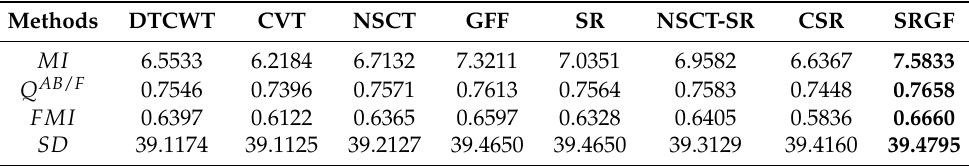
Figure 10. Fusion of “golf” images. Table 2. Quantitative assessments of “golf”